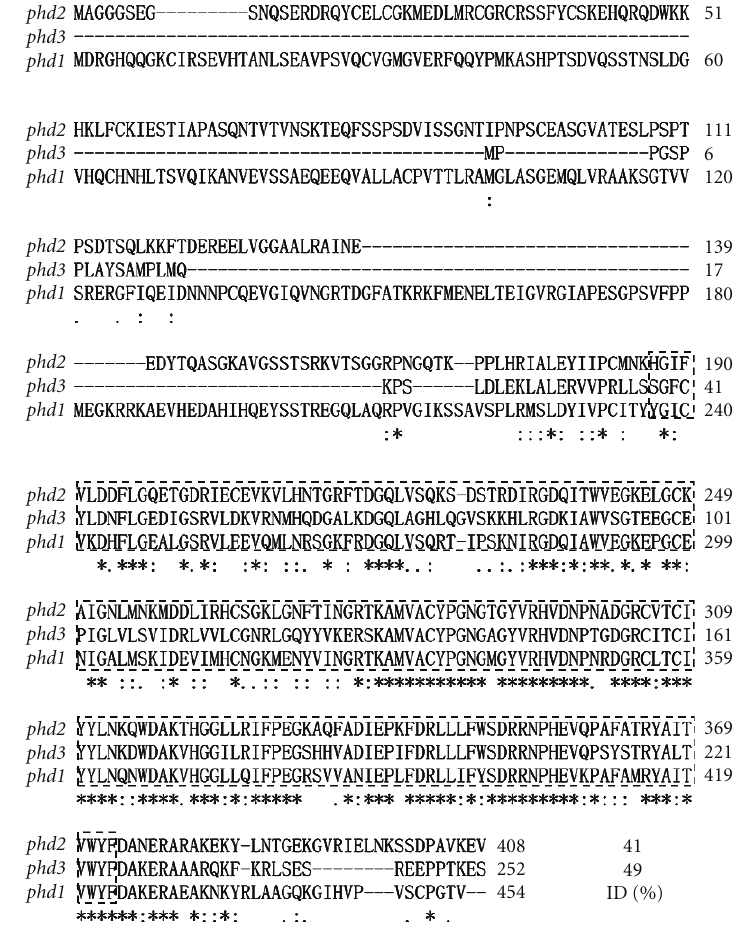
Figure 2: Comparison of the amino acid sequences of three Xenopus phds. Stars indicate identical amino acids in all three phds. Hyphens represent gaps introduced for optimizing the alignment. Dashed rectangles demarcate the highly conserved prolyl 4 hydroxylase domain. ID stands for the percentage of amino acid identity of Xenopus laevis phd1 in comparison with Xenopus phd2 and phd3